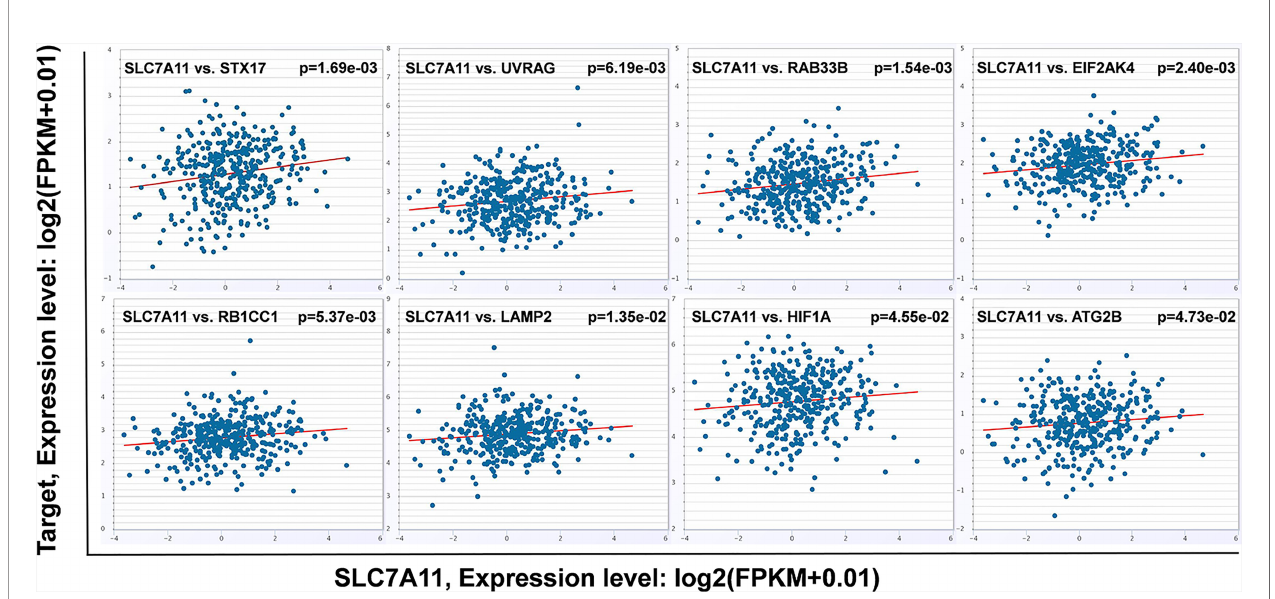
FIGURE 9 | The relationship between SLC7A11 and eight autophagy related genes. SLC7A11 act as a ceRNA for eight autophagy genes and positively co- expressed with these genes in 379 ovarian cancer tissues of TCGA cohort according to StarBase ( P< 0.05). The gene expression values from RNA-seq data were presented as log2 (FPKM + 0.01).